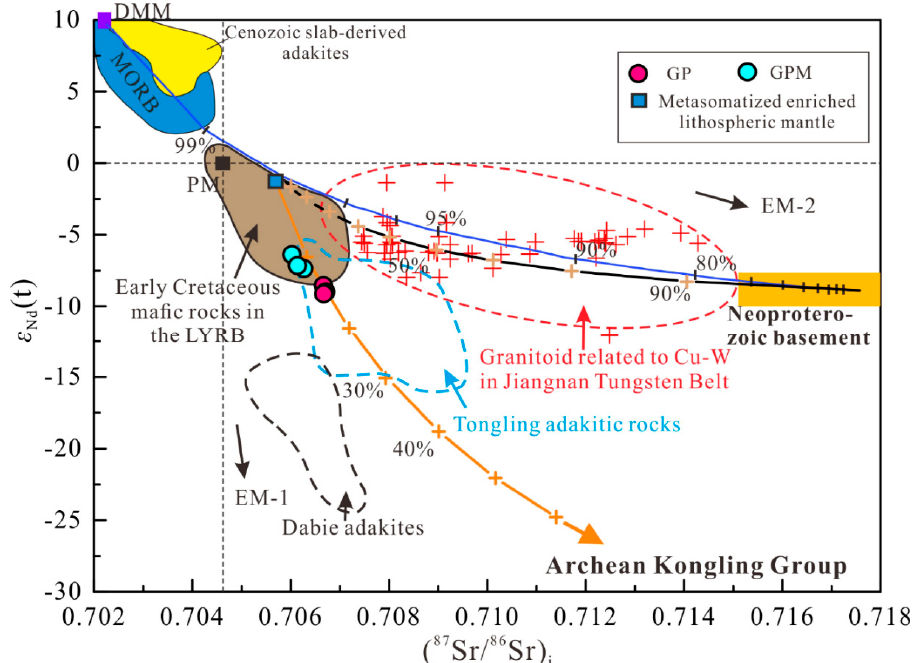
Figure 11. Initial Sr–Nd isotopic compositions of the Qiaomaishan intrusions. Note: End-members used for binary mixing calculated lines are depleted mantle (DMM) with Sr = 21 ppm, Nd = 0.4 ppm, and 87 Sr/ 86 Sr(t) = 0.7022; ε Nd (t) = 10 [46]. The metamorphic enriched lithospheric mantle is defined by the average values of the NNS formation volcanic rocks [37]. Archean Kongling Group with Sr = 315 ppm, Nd = 39 ppm, 87 Sr/ 86 Sr(t) = 0.7177, and ε Nd (t) = − 36.4 [47,48]. Data source: Dabie adakites [32], Tongling adakitic rocks [9,16], Early Cretaceous mafic rocks [16,34,37], granodiorites from Jiangnan W belt [10,44,49], PM, EM-1, and EM-2 [45].